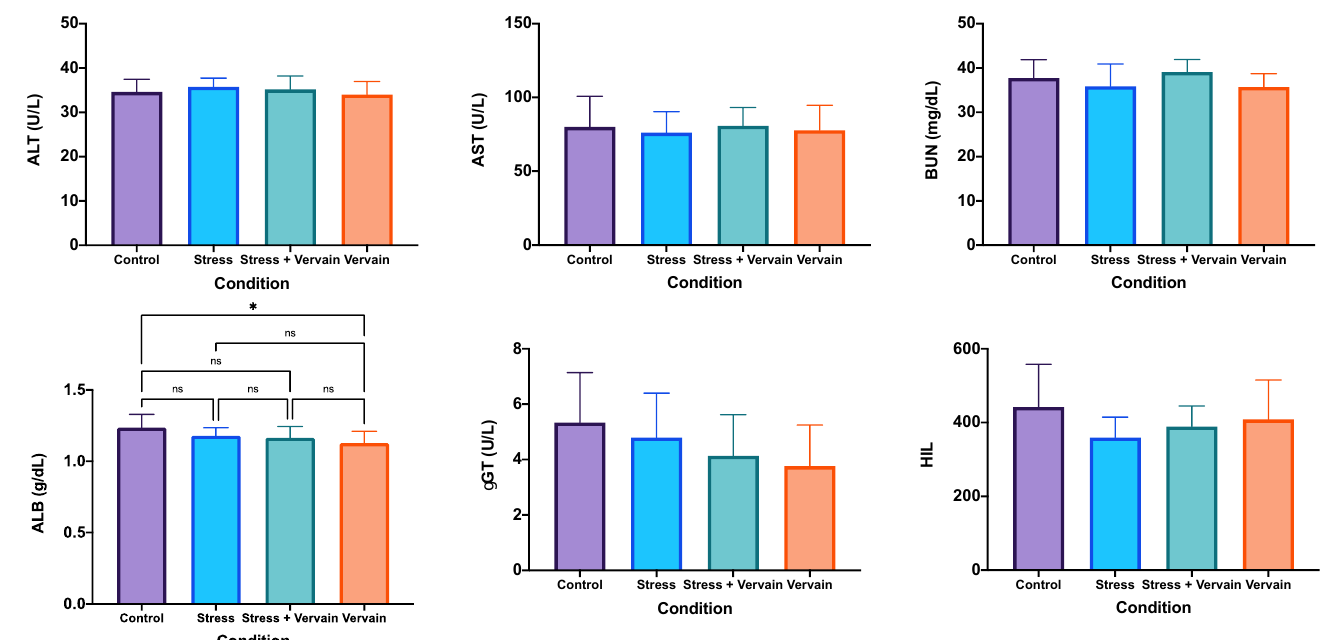
Figure 3. Blood biochemistry results for total protein (TP), lactate dehydrogenase (LDH), creatine kinase (CKI), creatinine (CREA), total bilirubin (TBI), direct bilirubin, aka conjugated bilirubin (DBI), total cholesterol (CHOL), low-density lipoproteins (ALDL), high-density lipoproteins (AHDL), glucose (GLU), alkaline phosphatase (ALP), uric acid (URCA), alanine transaminase (ALT), aspartate aminotransferase (AST), blood urea nitrogen (BUN), total albumin (ALB), and gama-glutamil transferase (γGT ), as well as hemolysis, icterus, and lipemia (HIL). Statistically different: * — p ≤ 0.05; **— p < 0.01; **** — p < 0.0001; ns — non-significant.